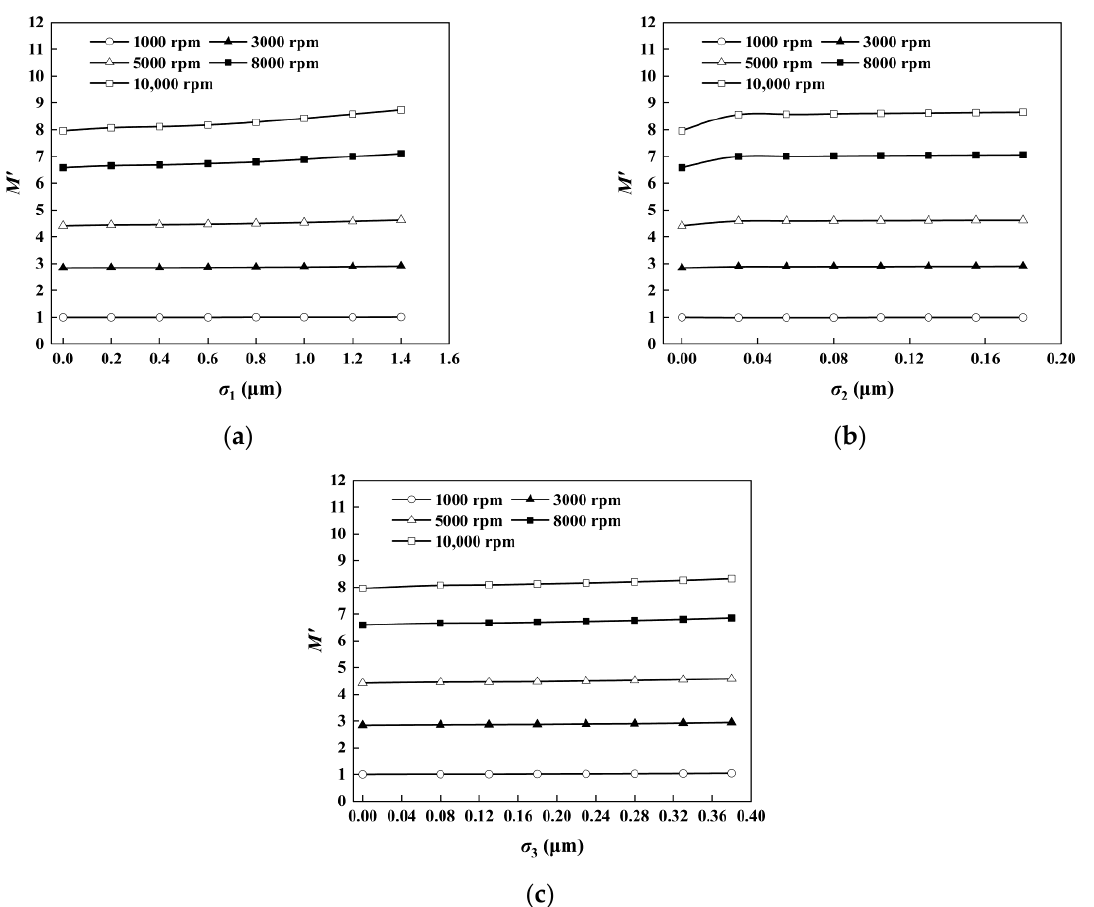
Figure 19. Effect of the roughness of different parts on friction torque: ( a ) the grooved zone of the rotating ring was rough, ( b ) the non-grooved zone of the rotating ring was rough, ( c ) the stationary ring surface was rough.